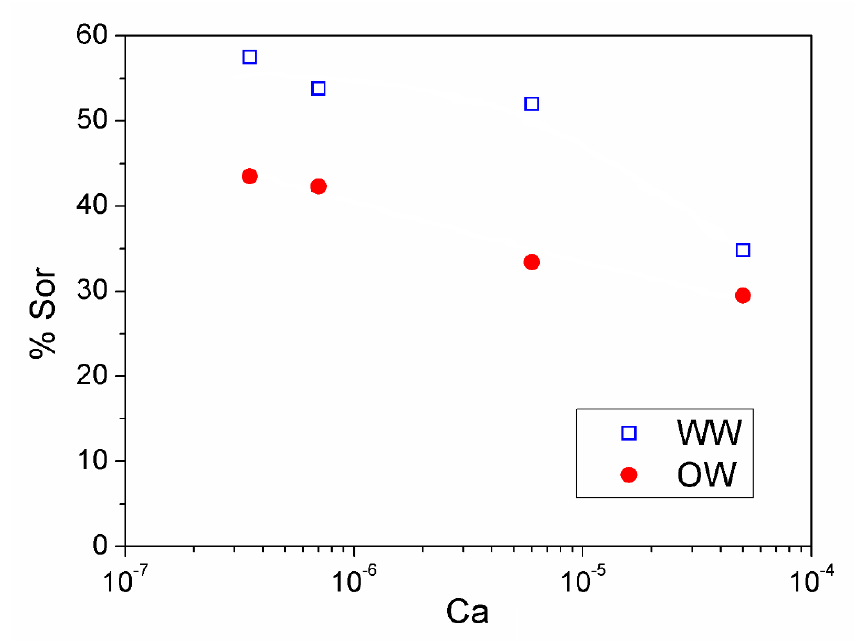
Figure 8. Residual oil saturation as a function of capillary number for water-wet and oil-wet model pore network.